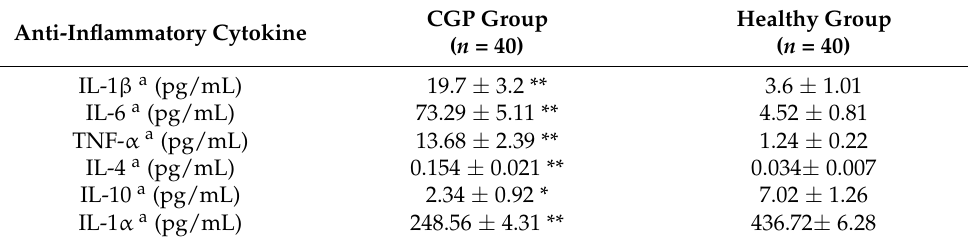
Table 5. Levels of anti-inflammatory cytokines in serum in patients with chronic generalized periodontitis. Anti-Inflammatory